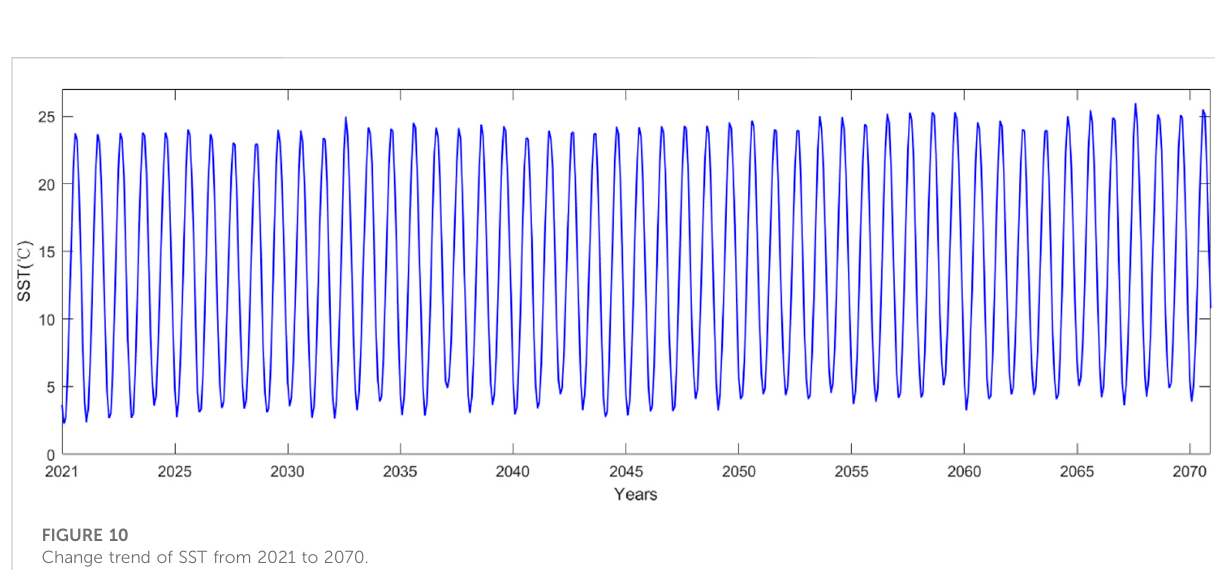
FIGURE 9 Respective prediction vs. consecutive prediction.